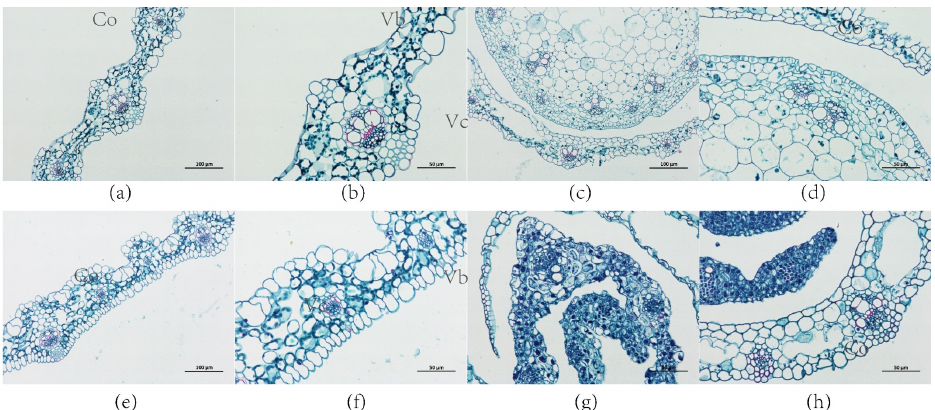
Figure 9. Morphological observation of leaves and stems with saffron solid green stain. ( a , b ) Leaf of control group; ( e , f ) leaf of transgenic plant; ( c , d )stem of control group; ( g , h )stem of transgenic plant; of control group; ( e , f ) leaf of transgenic plant; ( c , d ) stem of control group; ( g , h ) stem of transgenic a , c , e , 200×, scale bar = 100 μ m; b , d , f , g , h , 400×, scale bar = 50 μ m. Co, cortex; Vc, vascular column; plant; ( a , c , e ), 200 × , scale bar = 100 µ m; ( b , d , f , g , h ), 400 × , scale bar = 50 µ m. Co, cortex; Vc, vascular Vb, vascular bundle. Pi, pith. column; Vb, vascular bundle. Pi,